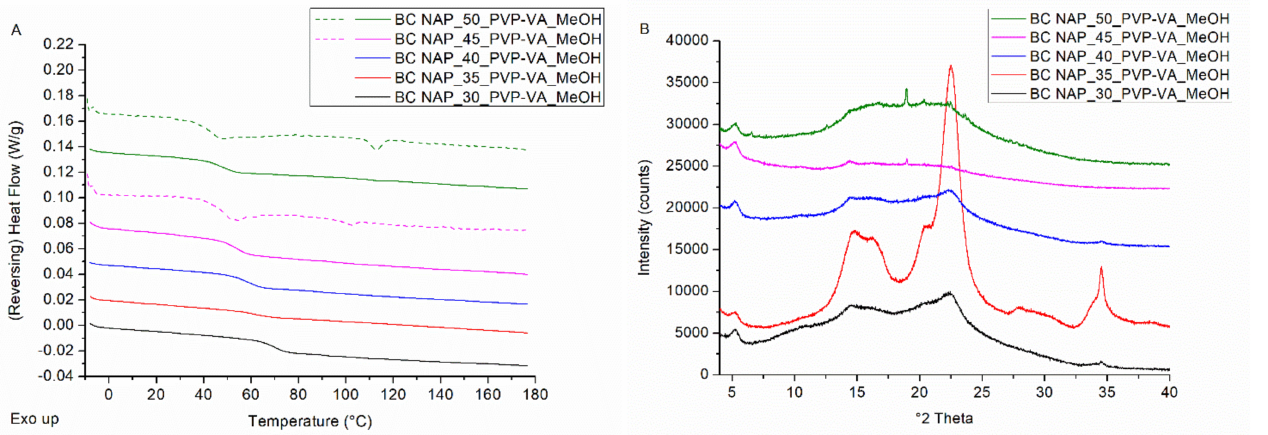
Figure 3. ( A ) mDSC thermograms of milled NAP–PVP-VA-coated beads (BC), with drug loadings from 30% (black) to 50% (green) by intermediate steps of 5%. The THF (dashed) and RHF (solid) signals are shown as arbitrary units. ( B ) Corresponding XRPD diffractograms. The intensities are shown as arbitrary